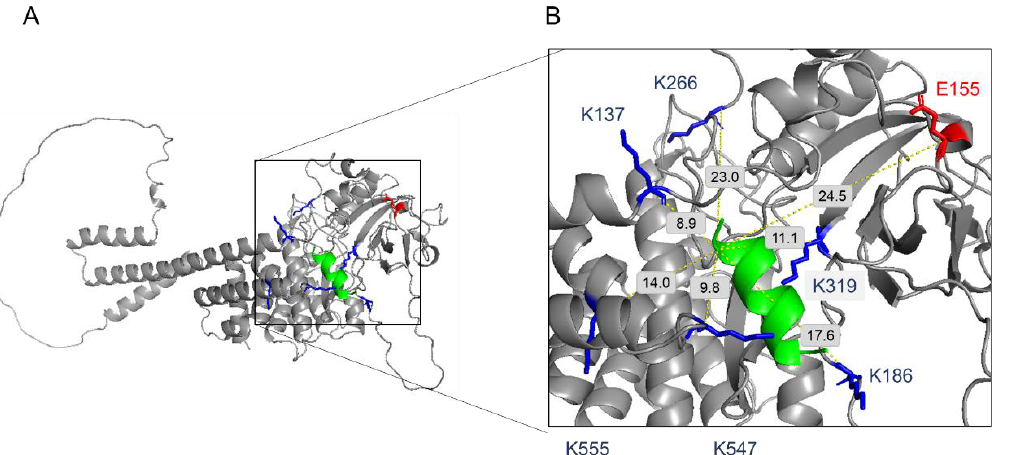
Figure 3. Map of the cross-link identified between the peptide CVP-198 and the hPink1 protein (Al- phaFold predicted model: Q9BXM7). ( A ) Residues involved in cross-linking contacts are highlighted in blue and red on the hPink1 protein. ( B ) CVP-198 and hPink1 cross-linking contacts: CVP-198 peptide (shown in green cartoon structure) and hPink1 protein (shown in grey cartoon structure) are positioned next to each other and inter-facial cross-links, involved Pink1 lysine residues, highlighted in the blue stick structure, and involved Pink1 glutamic acid residue, highlighted in the red stick structure, are displayed (dotted yellow lines). PyMoL (Schrodinger LLC) was used to generate the figure [24].